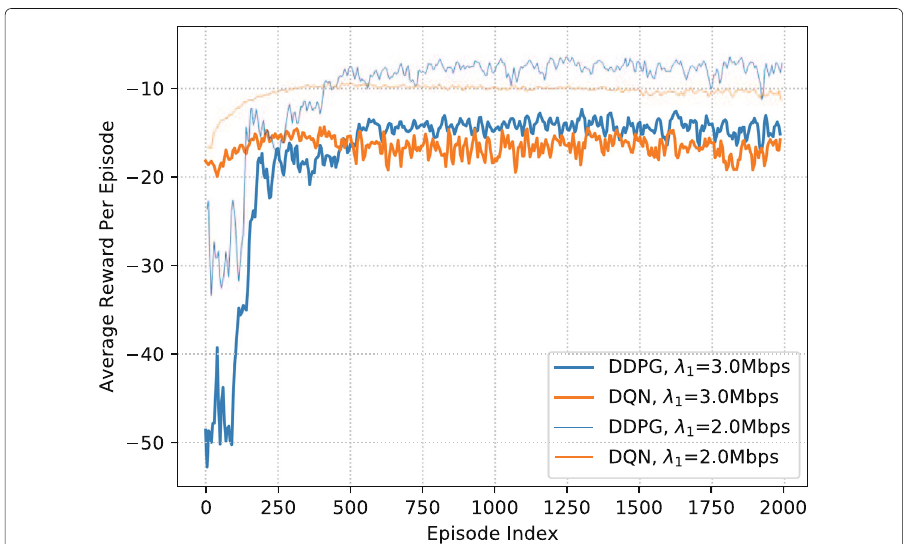
Fig. 5 Average reward per episode in the training process for a single user agent with w 1 =